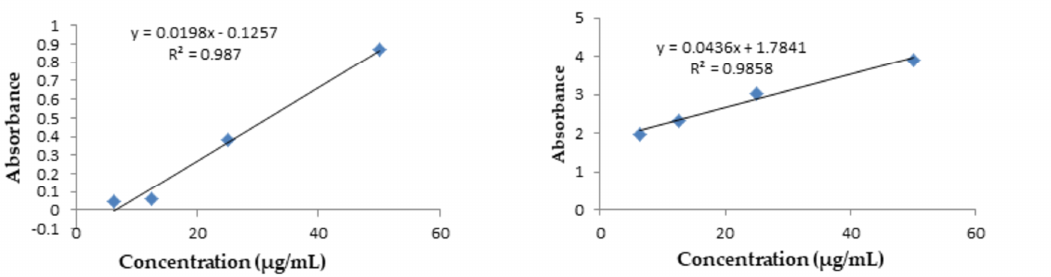
Figure 4. Ascorbic acid calibration curves (y = 0.0198x − 0.1257, R 2 = 0.987) for total antioxidant capacity (TAC) and (y = 0.0436x + 1.7841, R 2 = 0.9858) for total reducing power (TRP) estimations.